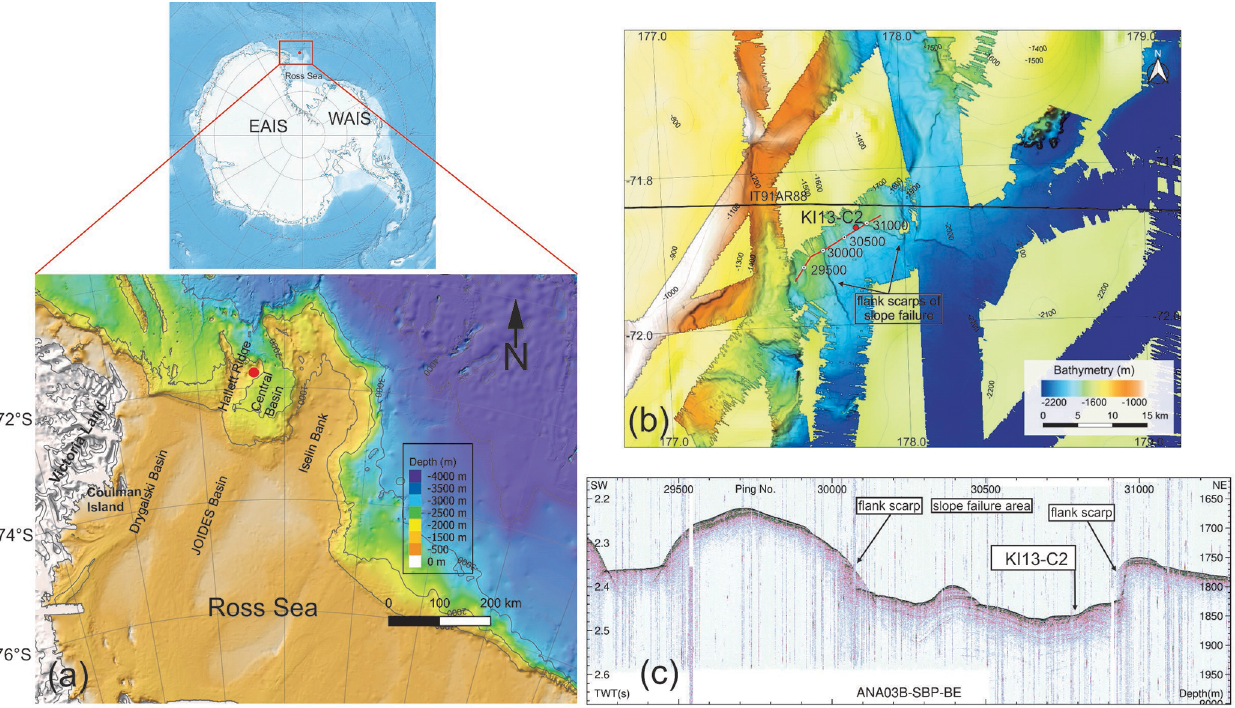
Figure 1. (a) Bathymetric map of the northwestern Ross Sea (modified from Arndt et al., 2013) and location of the KI13-C2 core (red dot). (b) Multibeam bathymetry imagery of the study area and core location. The black line indicates the multi-channel seismic (MCS) line IT91AR88. The red line and white dots represent the sub-bottom profile (SBP) data of ANA03B-SBP-BE, and labels refer to intervals of 500 ping numbers illustrated in the (c) SBP of ANA03B-SBP-BE and the core location. The Antarctica relief location map is from Wikimedia Commons